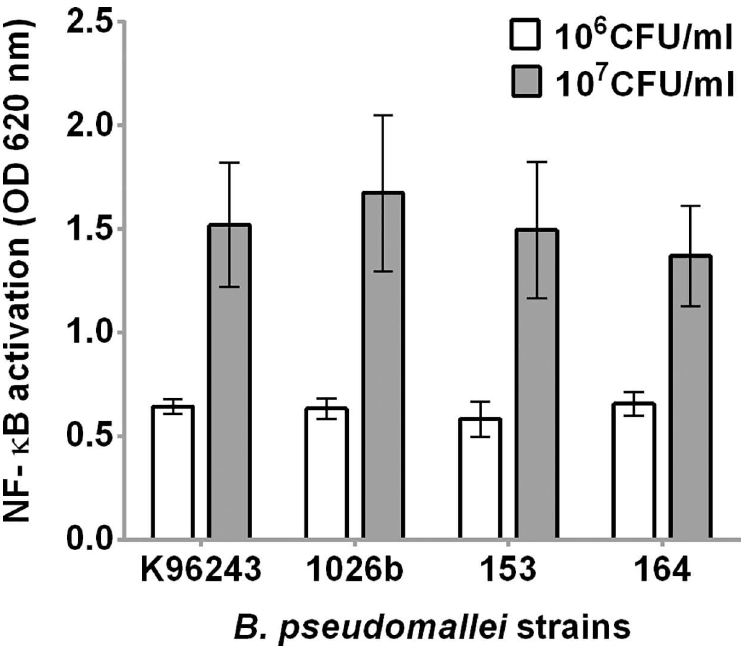
Fig 5. Activation of NF- κ B in HEK-Blue hTLR4 cells by four isolates of B . pseudomallei . HEK-Blue hTLR4 cells were stimulated with heat-killed B . pseudomallei at 10 6 or 10 7 CFU/ml at 37˚C in 5% CO 2 for 24 h. NF- κ B activation was determined in the supernatant by a SEAP reporter assay. Mean ± SD of three independent experiments were illustrated.